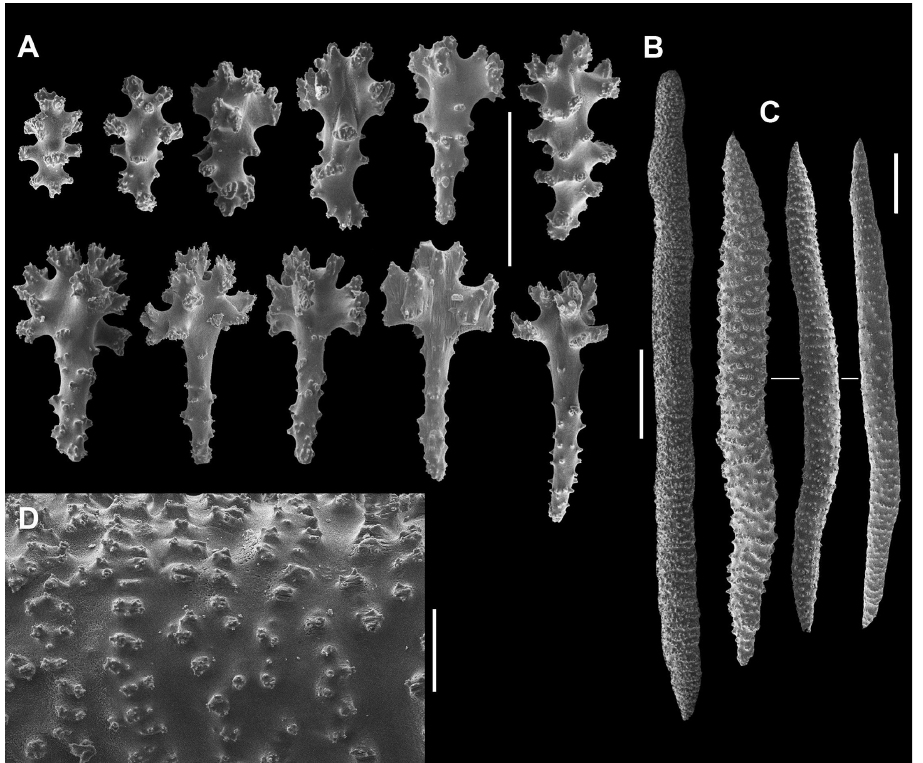
Figure 7. Sinularia lamellata RMNH Coel no. 12864. Sclerites of the colony base; A clubs of surface layer B–C spindles from interior base D tuberculation of spindles. Scale bars: 0.10 mm ( A, D ), 1 mm ( B, C